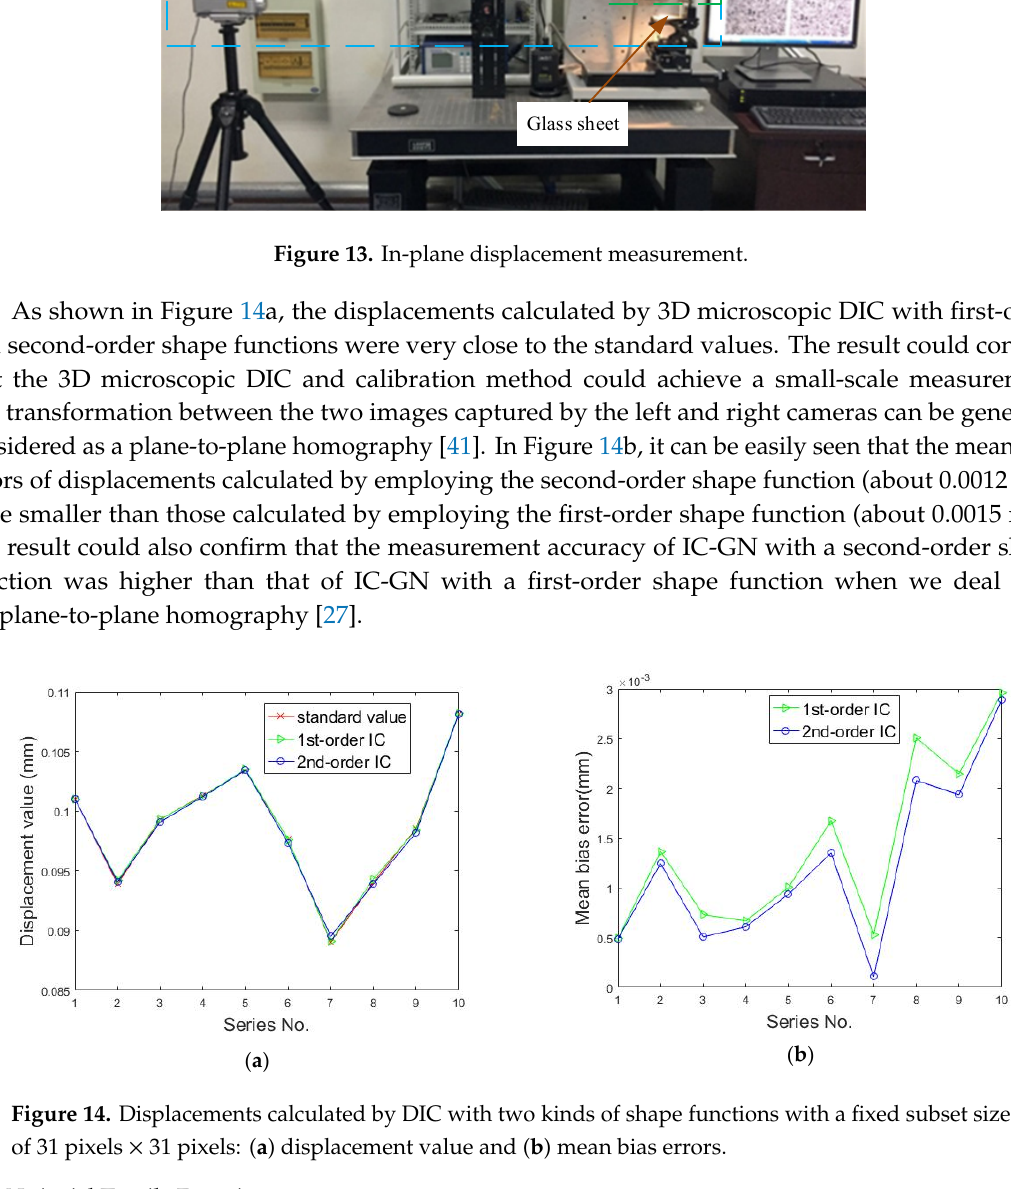
Figure 14. Displacements calculated by DIC with two kinds of shape functions with a fixed subset size of 31 pixels × 31 pixels: ( a ) displacement value and ( b ) mean bias errors.